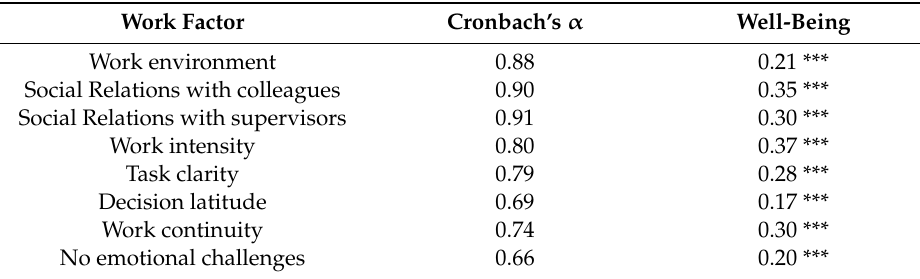
Table 2. Results of the reliability and criterion-related validity